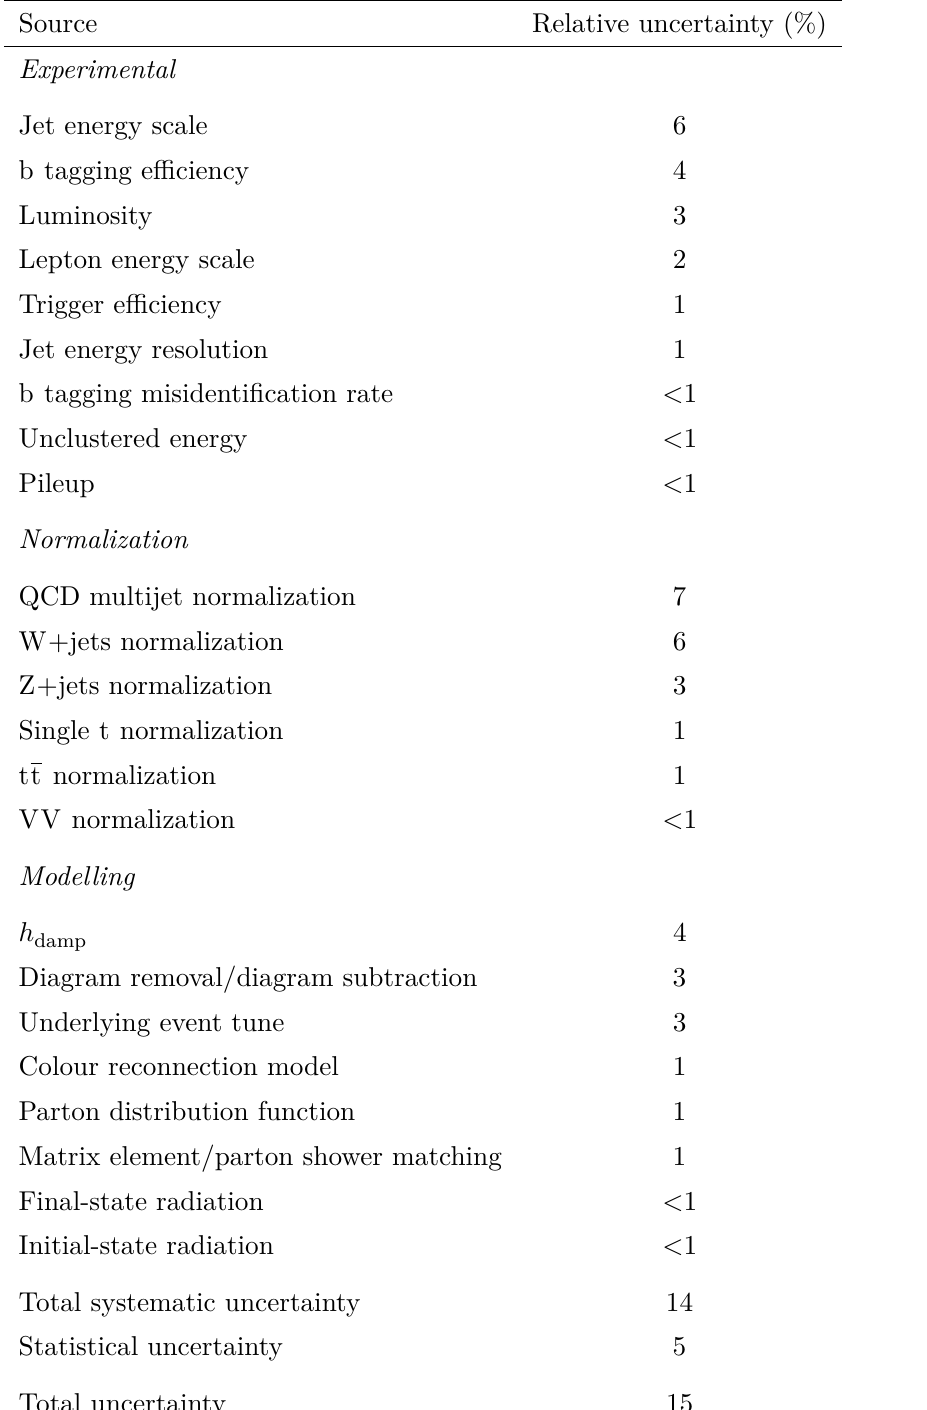
Table 2 . Relative uncertainty in the measured cross section from each source of systematic uncer- tainty for the combination of the muon and electron channels. The table is divided into experimen- tal, normalization, and modelling uncertainties. Uncertainties arising from the limited size of the simulated samples are included in the statistical